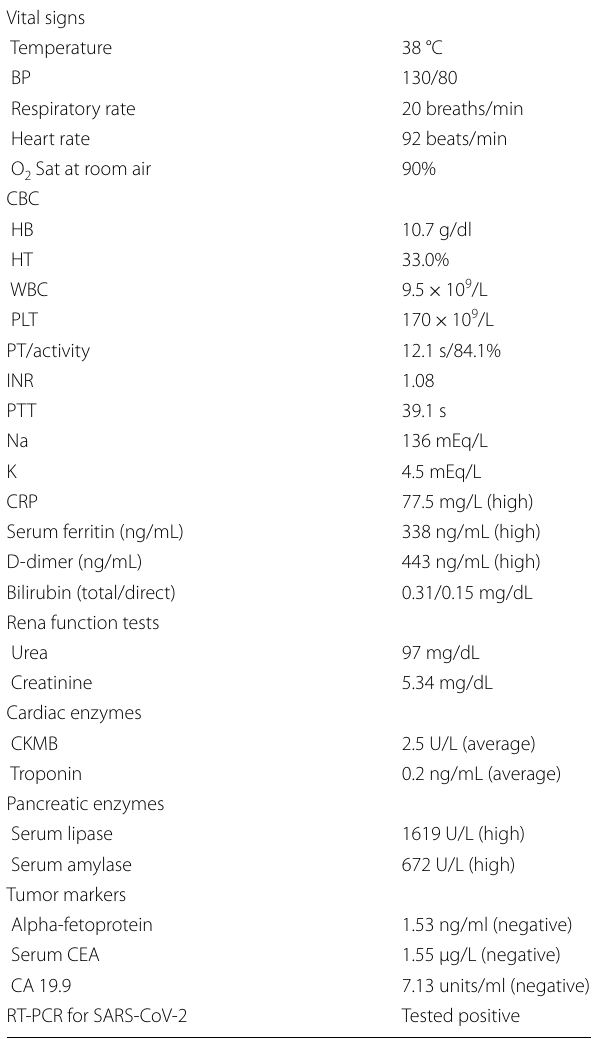
Table 1 The vital signs and initial lab investigations at the